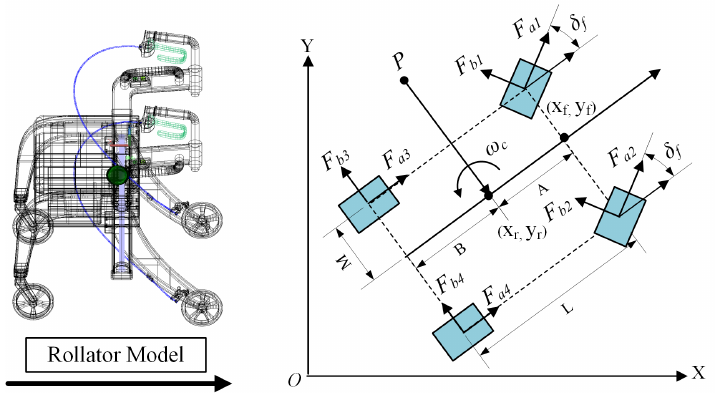
Figure 9. Model of the assistant elderly walker